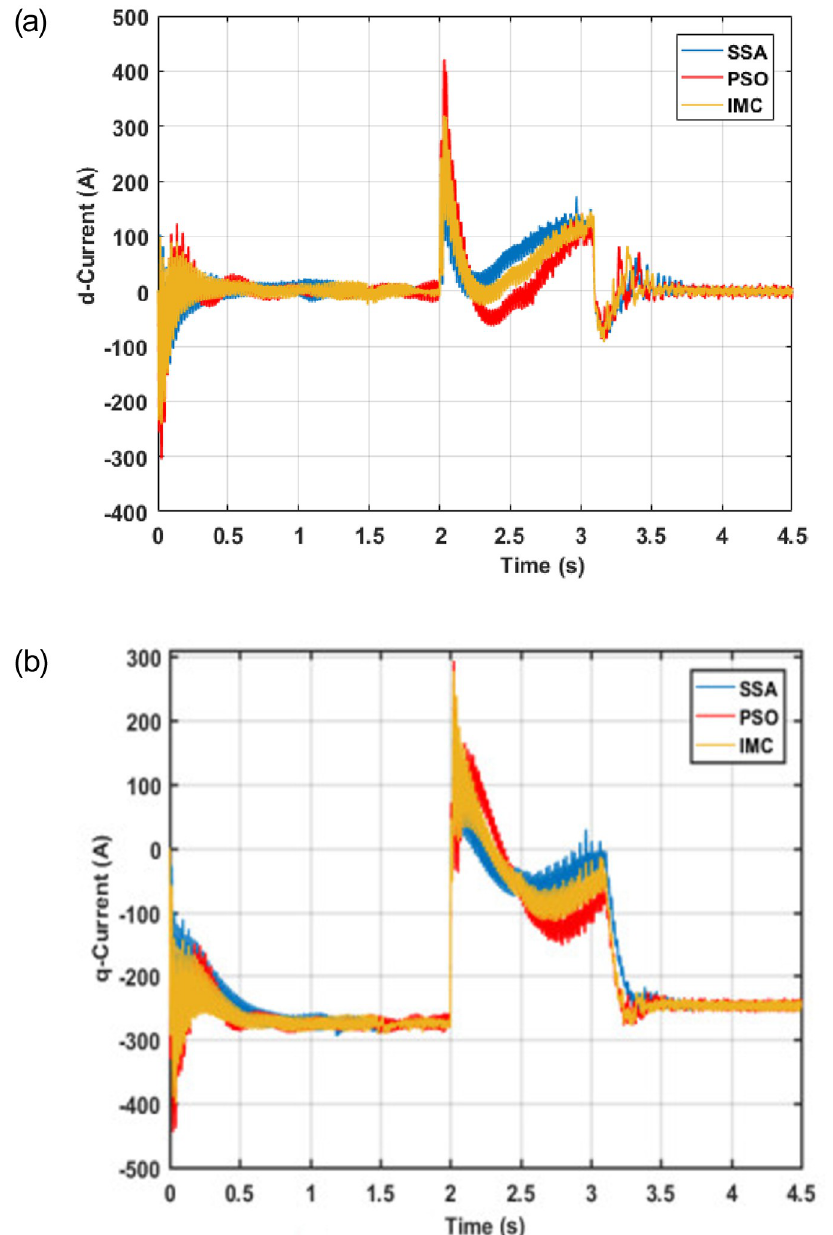
Fig 13. PW Current (a) d -component (b) q